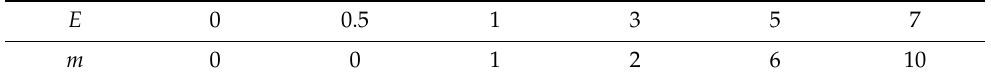
Table 2. The dominant modes under different airflow rotation strengths.